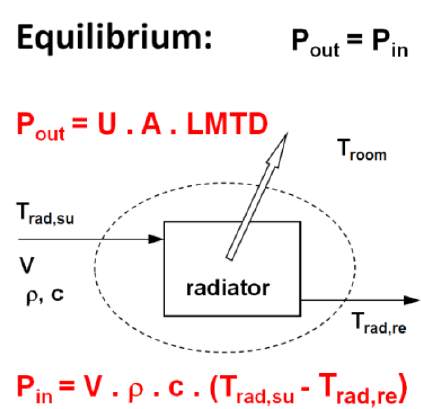
Fig. 17. – Stationary state, energy balance: P out = P in .